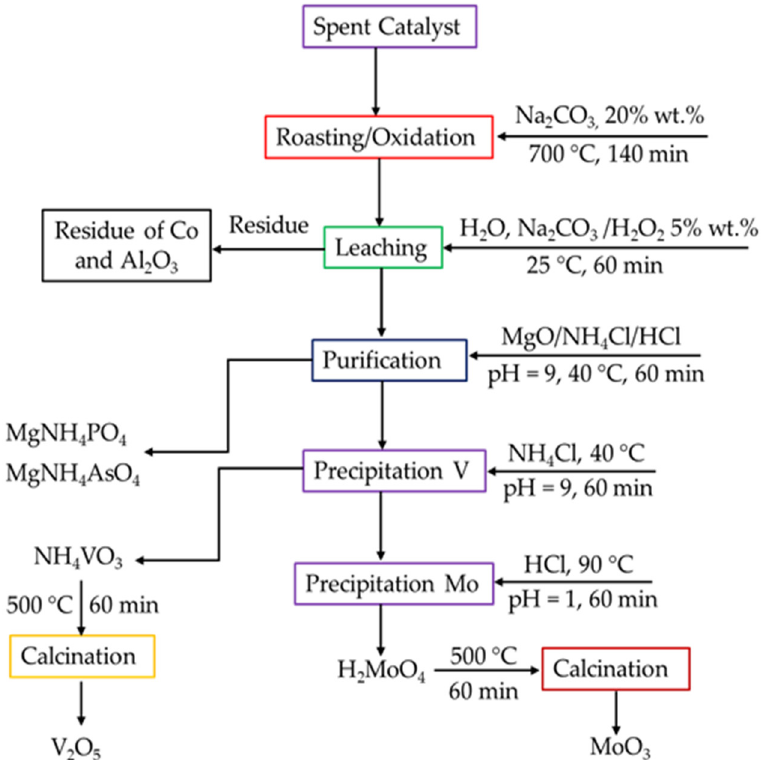
Figure 7. Flowsheet of the overall process.